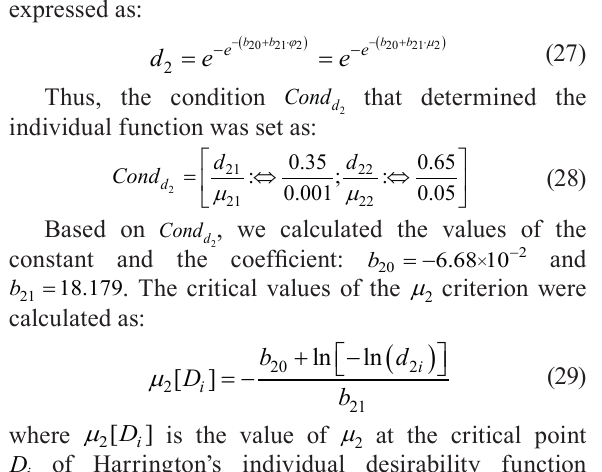
Figure 2 Graphic interpretation of Harrington’s individual desirability function given condition